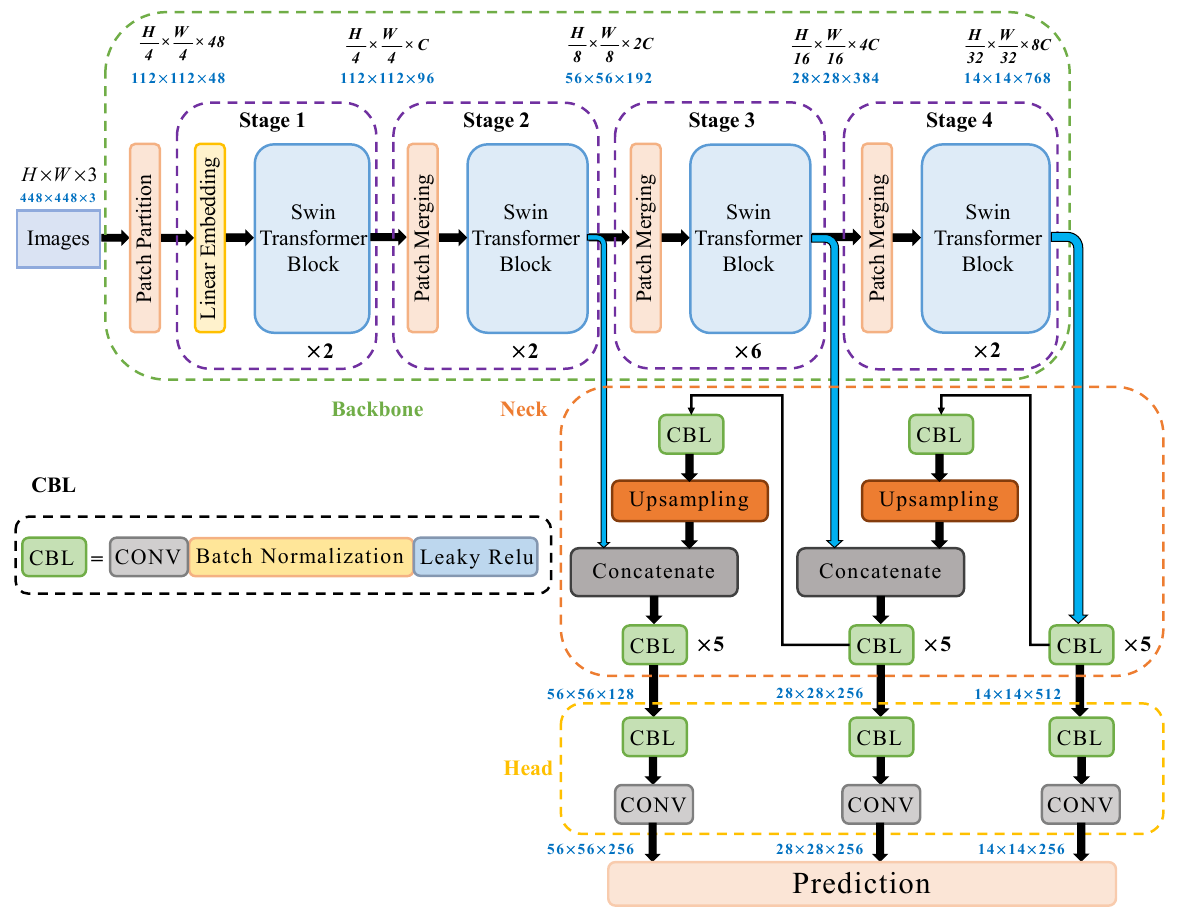
Figure 4. Schematic diagram of YOLO-Transformer network structure.